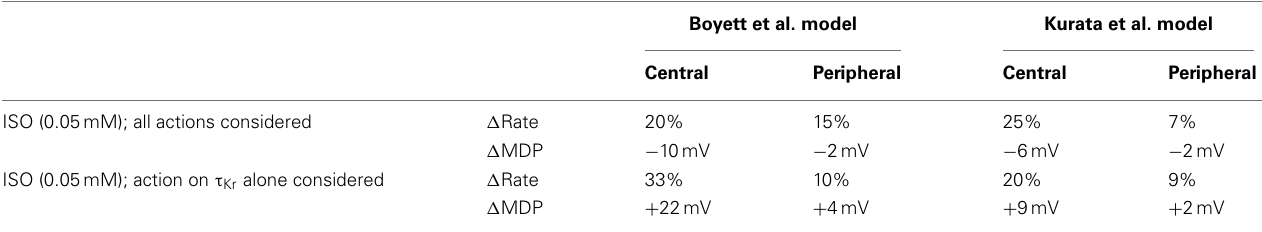
Table 1 | Effects of ISO and ISO-induced change in the deactivation rate of I Kr on the characteristics of pacemaking action